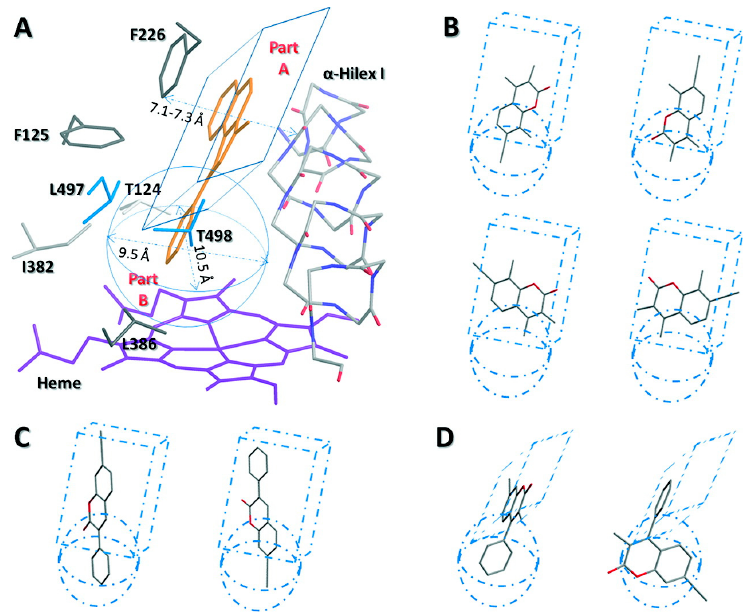
Figure 11. Reprinted with permission from reference 22. ( A ) Diagram of the active site cavity of P450 1A2: a narrow, but extended channel (part A ), and a spherical hydrophobic pocket (part B ). ( B ) The binding patterns of compound 7ETMC with P450 1A2, which suggests that the midsize 7-ethynylcoumarins could freely rotate in the narrow cavity (part A ) if only it is parallel with Phe-226 and the peptide bond in the α -helix I in order to form π – π interactions. ( C ) The possible binding patterns of compound 7E3PC with P450 1A2. Phenyl-facing-heme orientation (left) takes an obvious priority over the acetylene-facing-heme orientation (right). ( D ) The possible binding pattern (left) and impossible binding pattern (right) of compound 7E3M4PC with P450 1A2, suggesting that there is no reactive pose for the docking of 7E3M4PC with this enzyme.